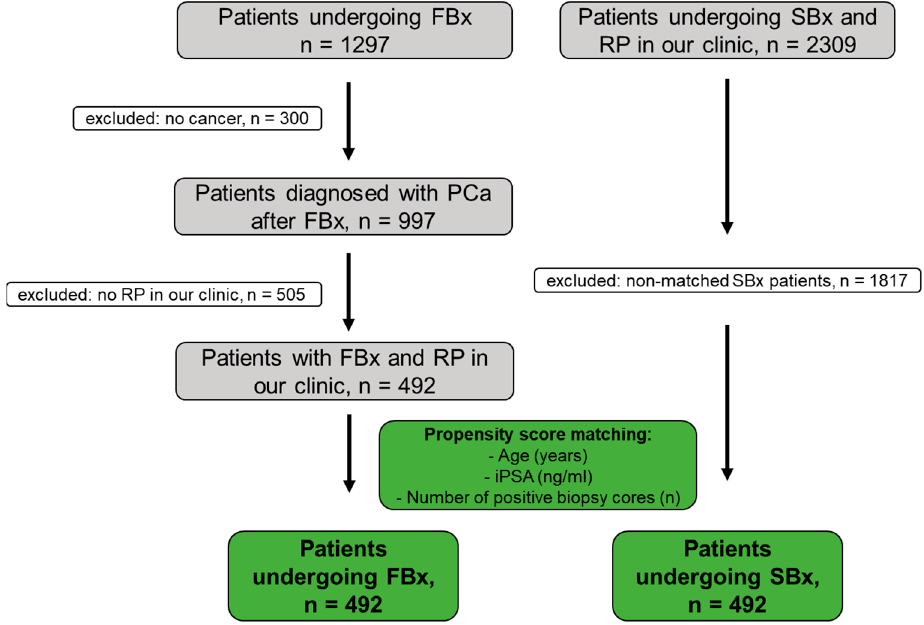
Figure 1. Cohort acquisition of the mpMRI–ultrasound fusion ‐ guided prostate biopsy (FBx) and the standardized biopsy (SBx) for propensity score matching. PCa: prostate cancer, RP: radical prosta ‐ tectomy.